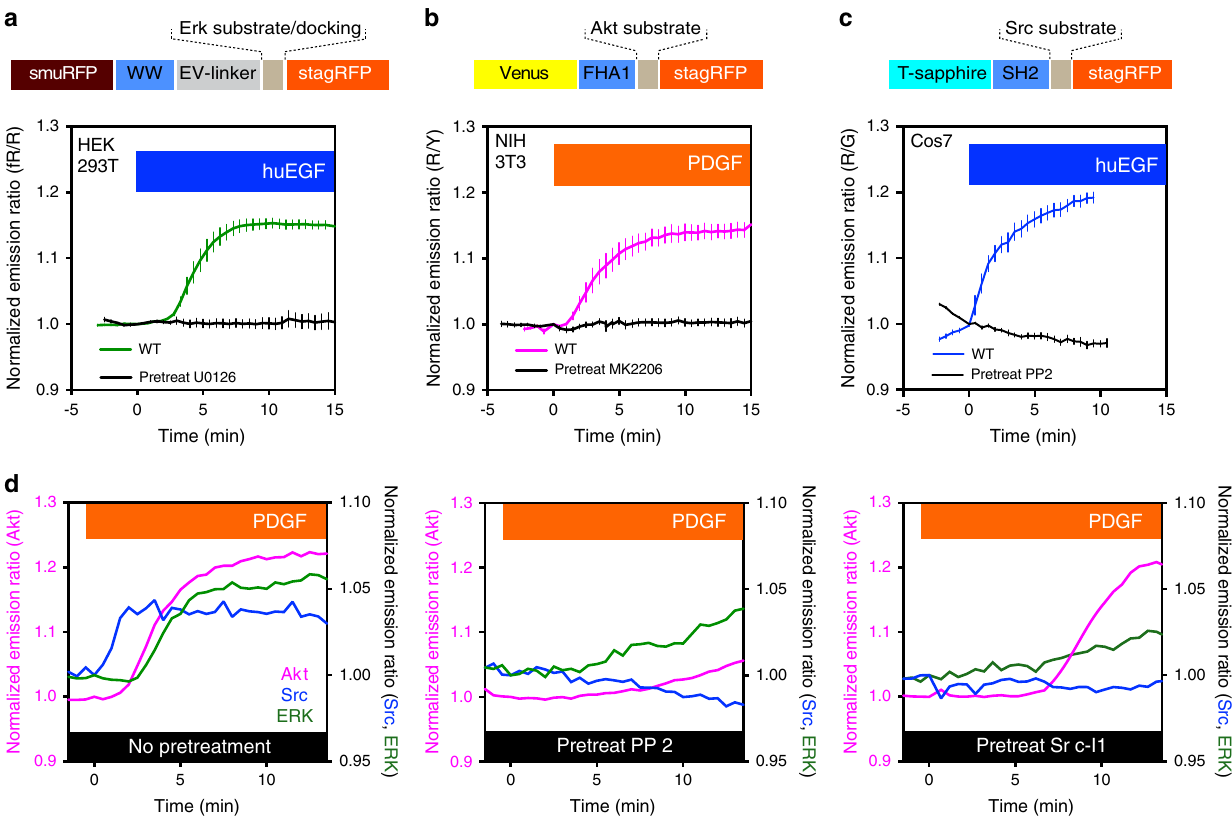
Fig. 4 Multiplexing the kinase activities of Akt, Src, and ERK in single live cells utilizing three biosensors containing stagRFP. a The red-far-red biosensor fRR-EKARev could reliably monitor ERK activity in response to 100 ng/mL huEGF stimulation in the red-far-red region, shown as changes in normalized emission ratio (far-red/red) (WT, n = 12 biologically independent cells; and pretreatment with 20 µ M U0126, n = 5). b The yellow-red Akt activity reporter incorporating stagRFP reliably detects Akt activity in NIH 3T3 cells in response to 50 ng/mL PDGF stimulation, shown as changes in normalized emission ratio (red/yellow) (WT, n = 6; and pretreatment with 3 µ M MK2206, n = 8). c The green-red Src activity reporter incorporating stagRFP reliably detects Src activity in Cos7 cells in response to 100 ng/mL huEGF stimulation, shown as changes in normalized ratio (red/green) (green for T-sapphire emission) (WT, n = 6; and pretreatment with 10 µ M PP2, n = 12). The mean ratio ± SEM is displayed for a – c . d Multiplexed imaging revealed a potential kinetic relationship between Src, Akt, and ERK upon 50 ng/mL PDGF stimulation. Representative curves showing PDGF-induced responses of green-red based Src activity biosensor (blue), yellow-red based Akt activity biosensor (red), and ERK activity biosensor (green) in control cells without pretreatment (left), cells pretreated with 10 µ M PP2 (middle), or 10 µ M Src-I1